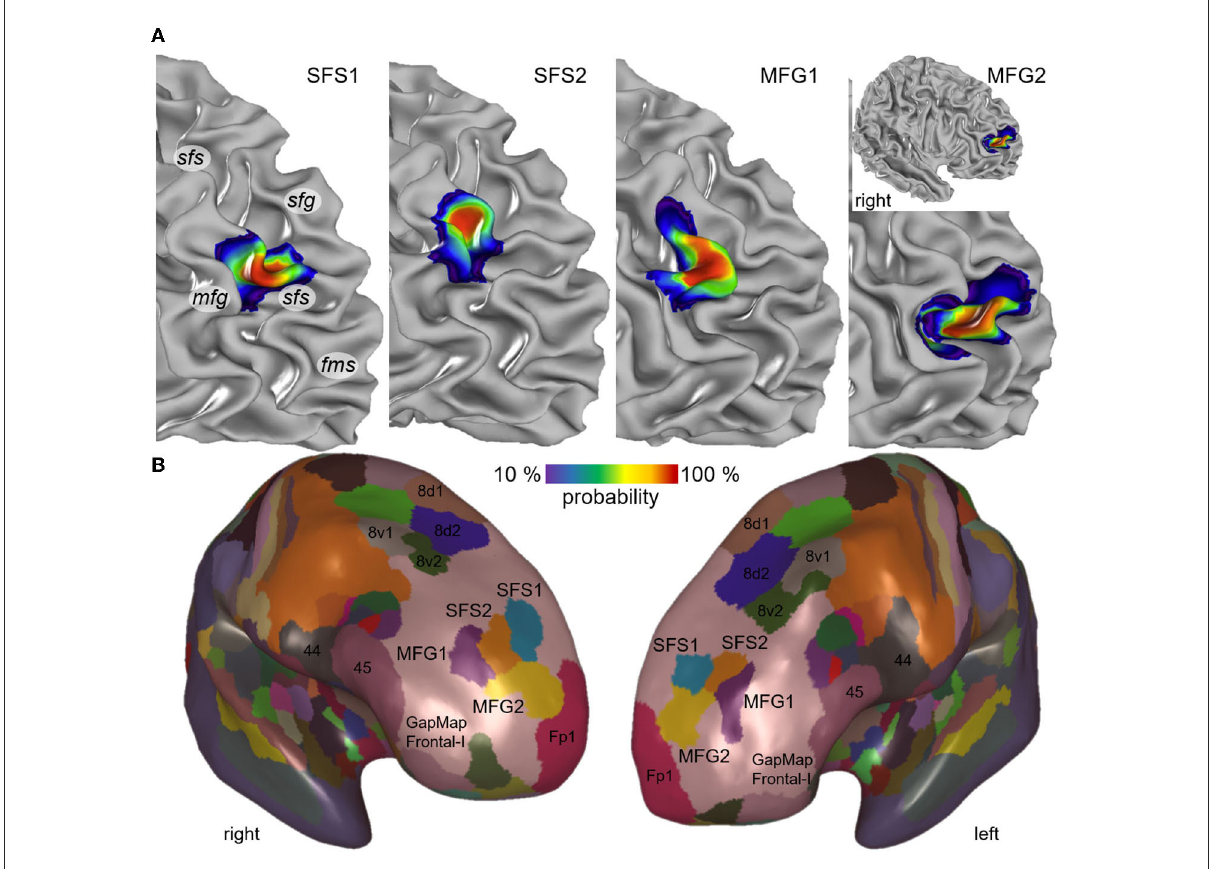
FIGURE10 Maximum probability map and probability maps of the newly identified areas. The individual probability maps of the new areas SFS1, SFS2, MFG1, and MFG2 are illustrated on the right prefrontal hemisphere of the stereotaxic MNI Colin27 template brain (A) . Maps are depicted in smooth white matter mode to demonstrate the area localization on sulci and gyri ( sfg , superior frontal gyrus; sfs , superior frontal sulcus; mfg , middle frontal gyrus; fms , frontomarginal sulcus). The probability maps indicate color-coded interindividual variability. Values from 10 to 100% (blue to red) describe the degrees of overlap, e.g., red regions correspond to at least 82% probability. The non-overlapping surface representation of MNI Colin27 illustrates the position of SFS1 (blue), SFS2 (orange), MFG1 (purple), and MFG2 (yellow) in conjunction with the neighboring frontal pole area Fp1 (magenta), posterior DLPFC areas (8d1, 8d2, 8v1, and 8v2) and areas of Broca’s region (44 and 45) on an inflated brain surface (B) . The newly identified areas were located in the GapMap Frontal-I (rose) of yet unmapped prefrontal cortex areas. Probability map and maximum